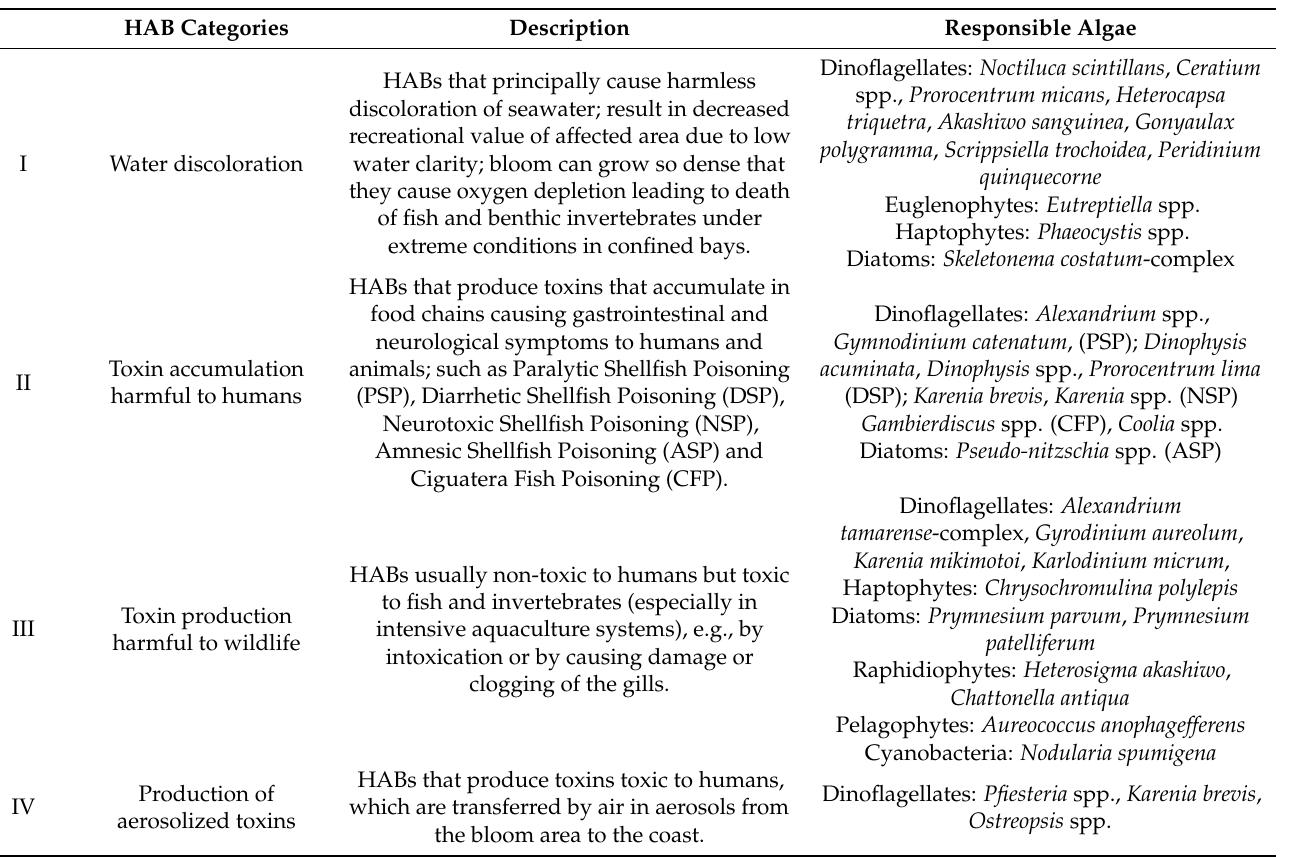
Table 1. Harmful Algal Bloom (HAB) categories and the main responsible algae for the formation of the bloom [7,12]. HAB